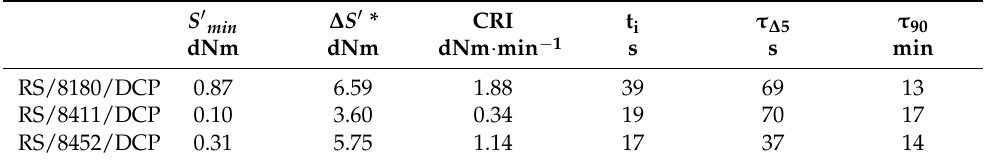
Table 1. Curing characteristic at 160 ◦ C. The minimum elastic torque S (cid:48) min , the increase of elastic modulus during curing ∆ S (cid:48) , cure rate index CRI, incubation time t i , the scorch time τ ∆ 5 , optimal curing time τ 90 .